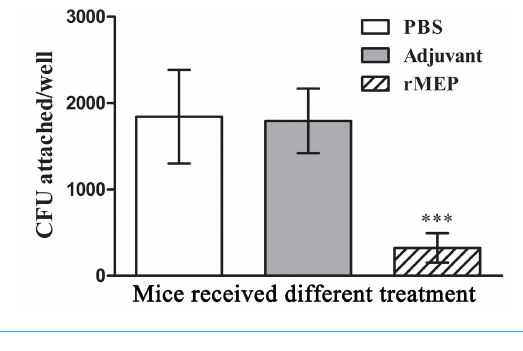
Figure 4: Antibodies against rMEP block the binding of A. baumannii to collagen type IV (n = 6). A. baumannii ATCC strain 19606 cells were incubated for 30 minutes with sera from six mice in each group (1/500 dilution) and tested for binding to immobilised collagen type IV. Each well contained a serum sample from one mouse. Data are shown as the mean of the attached bacterial CFU per well ± SD. *** p <0.001 compared with the PBS- or adju- vant-treated groups.